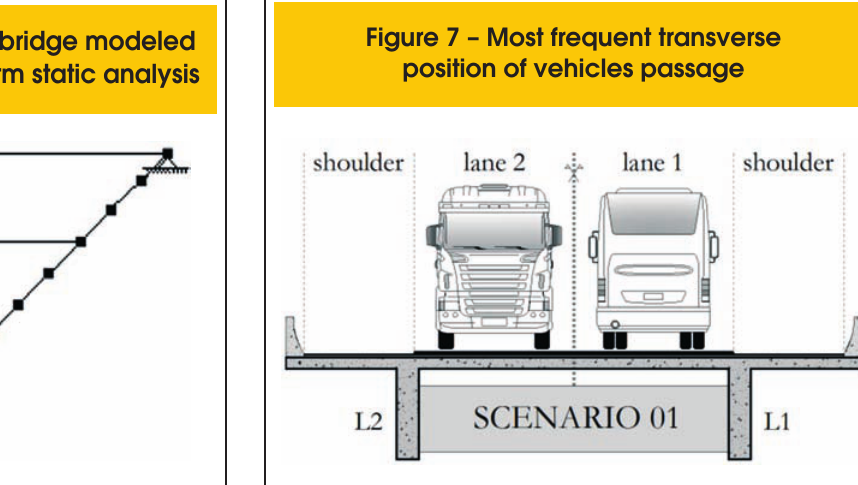
Figure 6 – Typical single span bridge modeled as a 3D grid structure to perform static analysis